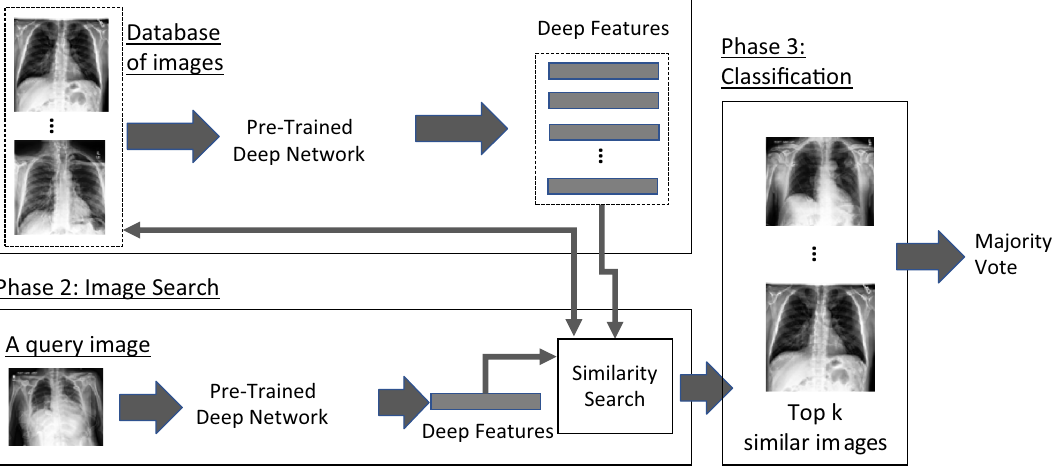
Figure 2. An overview of using image search as a classifier to recognize pneumothorax in chest X-ray images. Phase 1: Tagging images with Features. Phase 2: Image Search (distance calculation between the query features and all other features in the database). Phase 3: Classification (the majority voting of the retrieved images as a